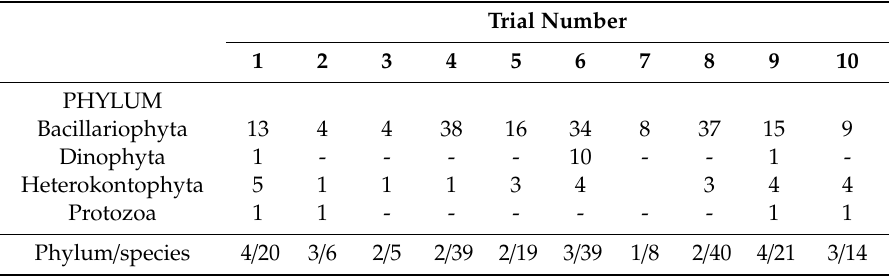
Table 6. Number of phylum and species of ≥ 10 and < 50 sized organisms in shipboard tests.